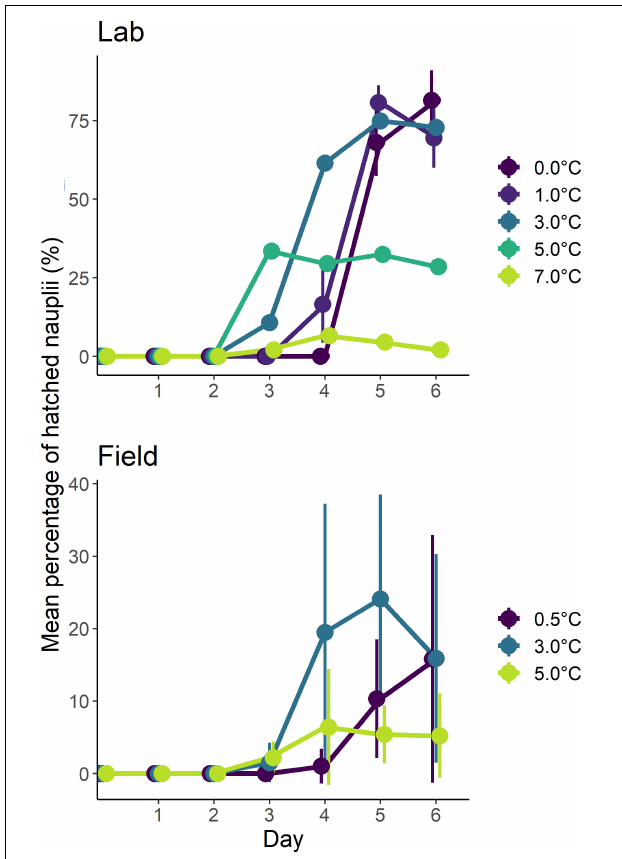
FIGURE 4 | Effect of temperature on rate of embryonic development. The mean percentage of nauplii hatched for each of the temperature replicates for each day of the incubation experiments. Each data point has been slightly offset to ensure the bar showing standard deviation is